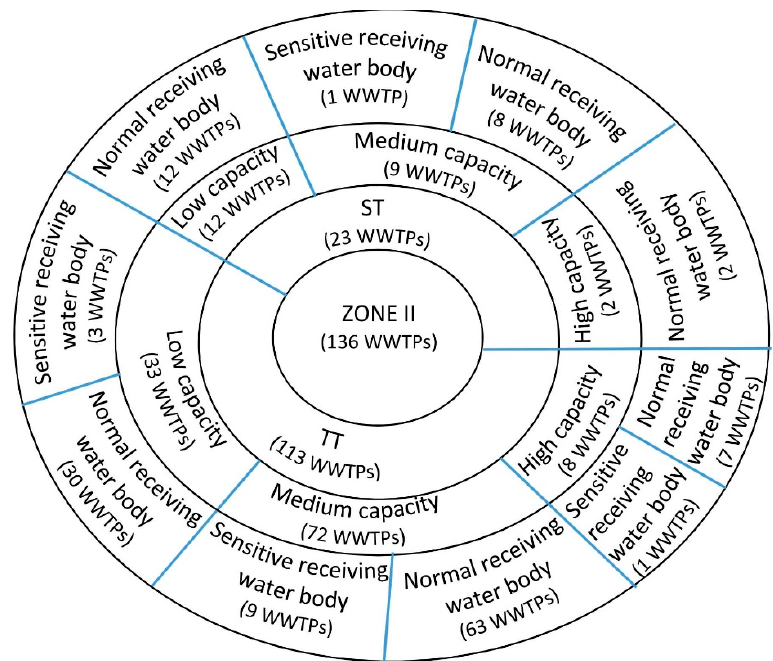
Figure 1. Categorization of WWTPs for Zone I of EHZ.